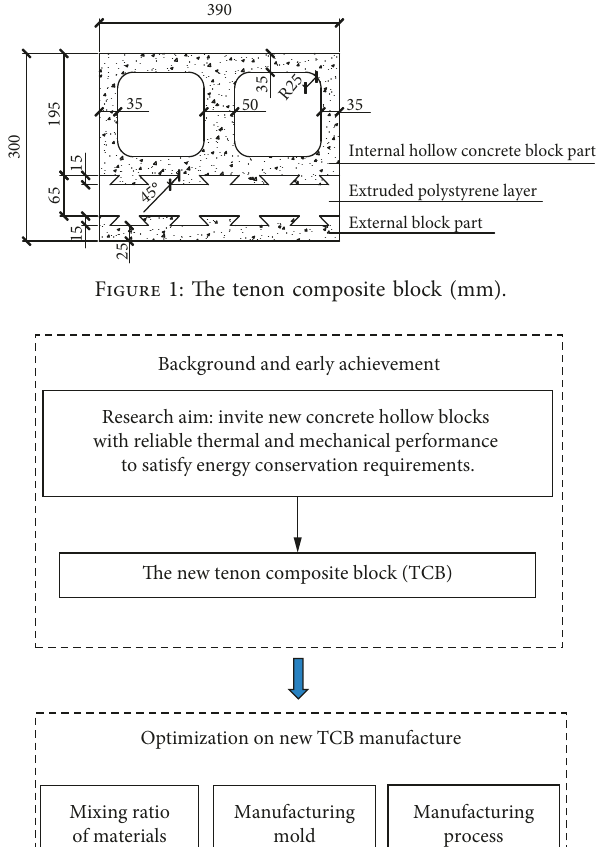
Table 1: Energy consumption percentage of different building parts.